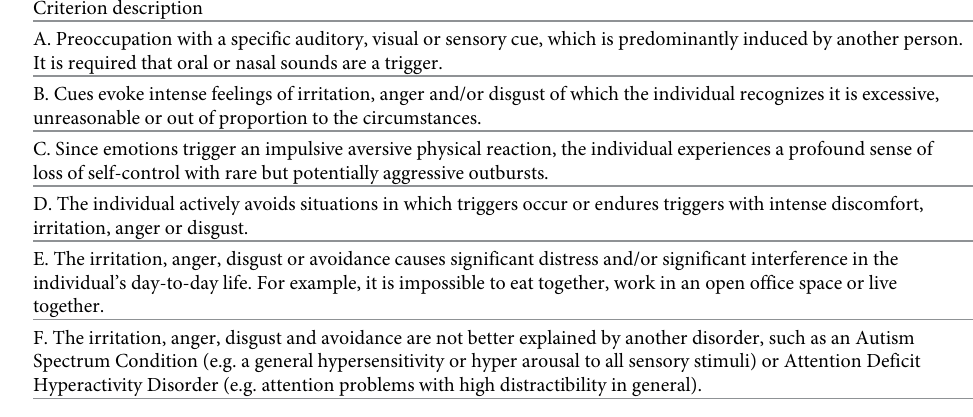
Table 1. Revised diagnostic criteria for